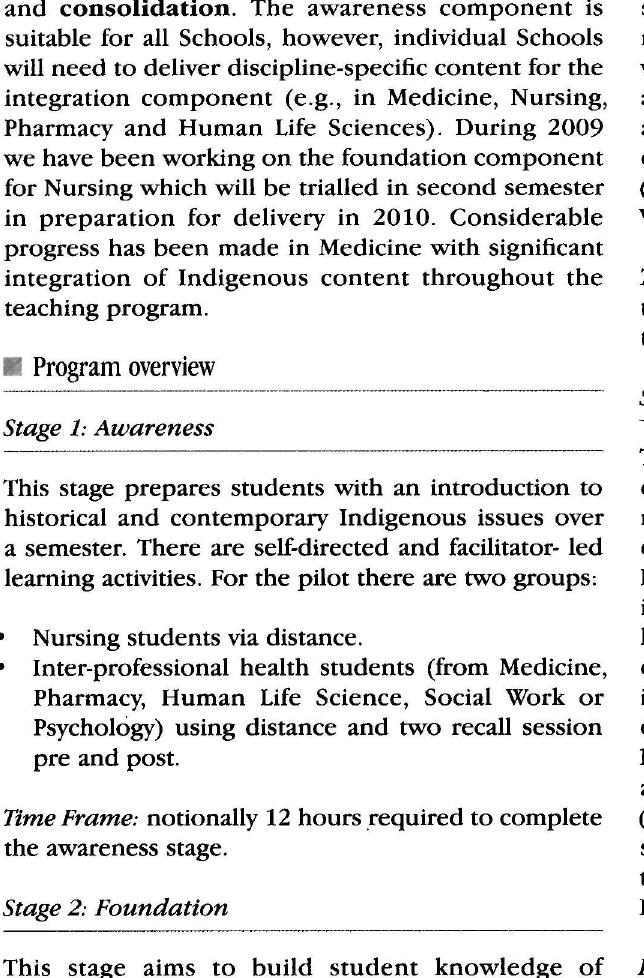
Table 4. The proposed timeframe for implementation within health related degrees at